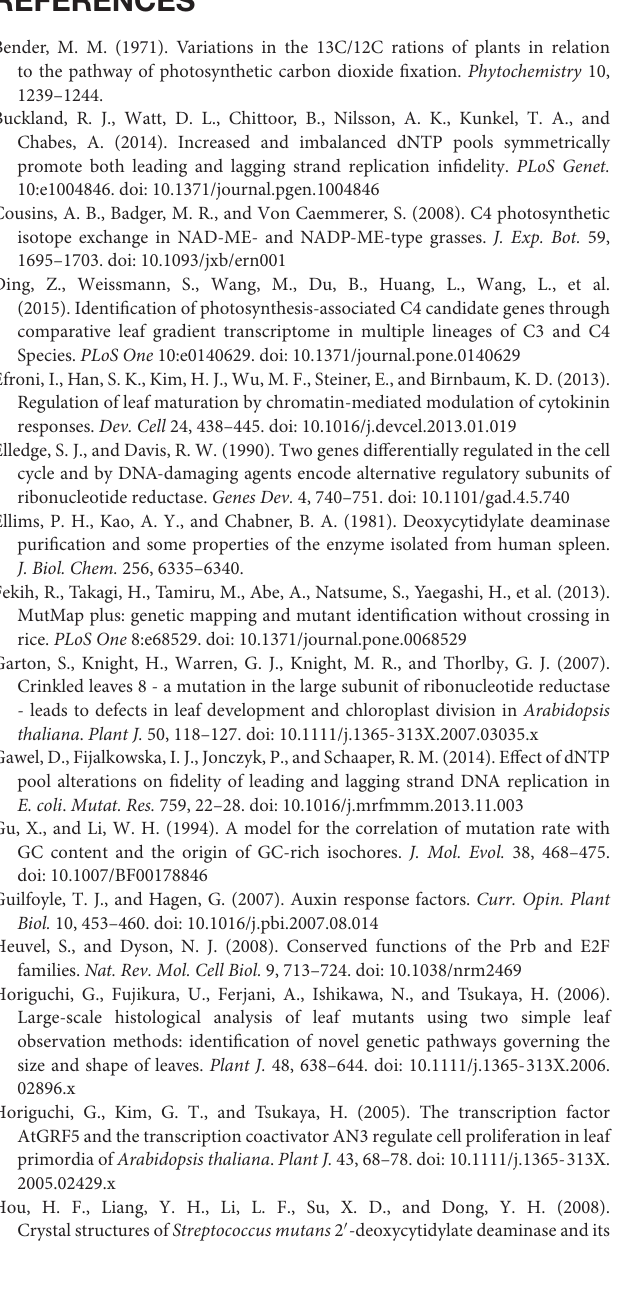
TABLE S8 | DEGs in phenotype-associated TFs families. TABLE S9 | The qRT-PCR primers for the validation of RNA-seq result. TABLE S10 | Transcript levels of C 4 candidate genes. FIGURE R1 | Top panel, the red cycles show two leaf veins of sistl2 , the red box shows the cell between two leaf veins. The bottom panel shows the chloroplast (red arrow) of the cell in the red box in the top panel. The granum lamellas can be observed clearly in the chloroplast. FIGURE R2 | (A) Kranz structure of Yugu1, the S. italica wild type. A chloroplast of BSC was pointed out by a blue cycle and magnified in (B) . (B) The red arrows show the structures like grana in BSC